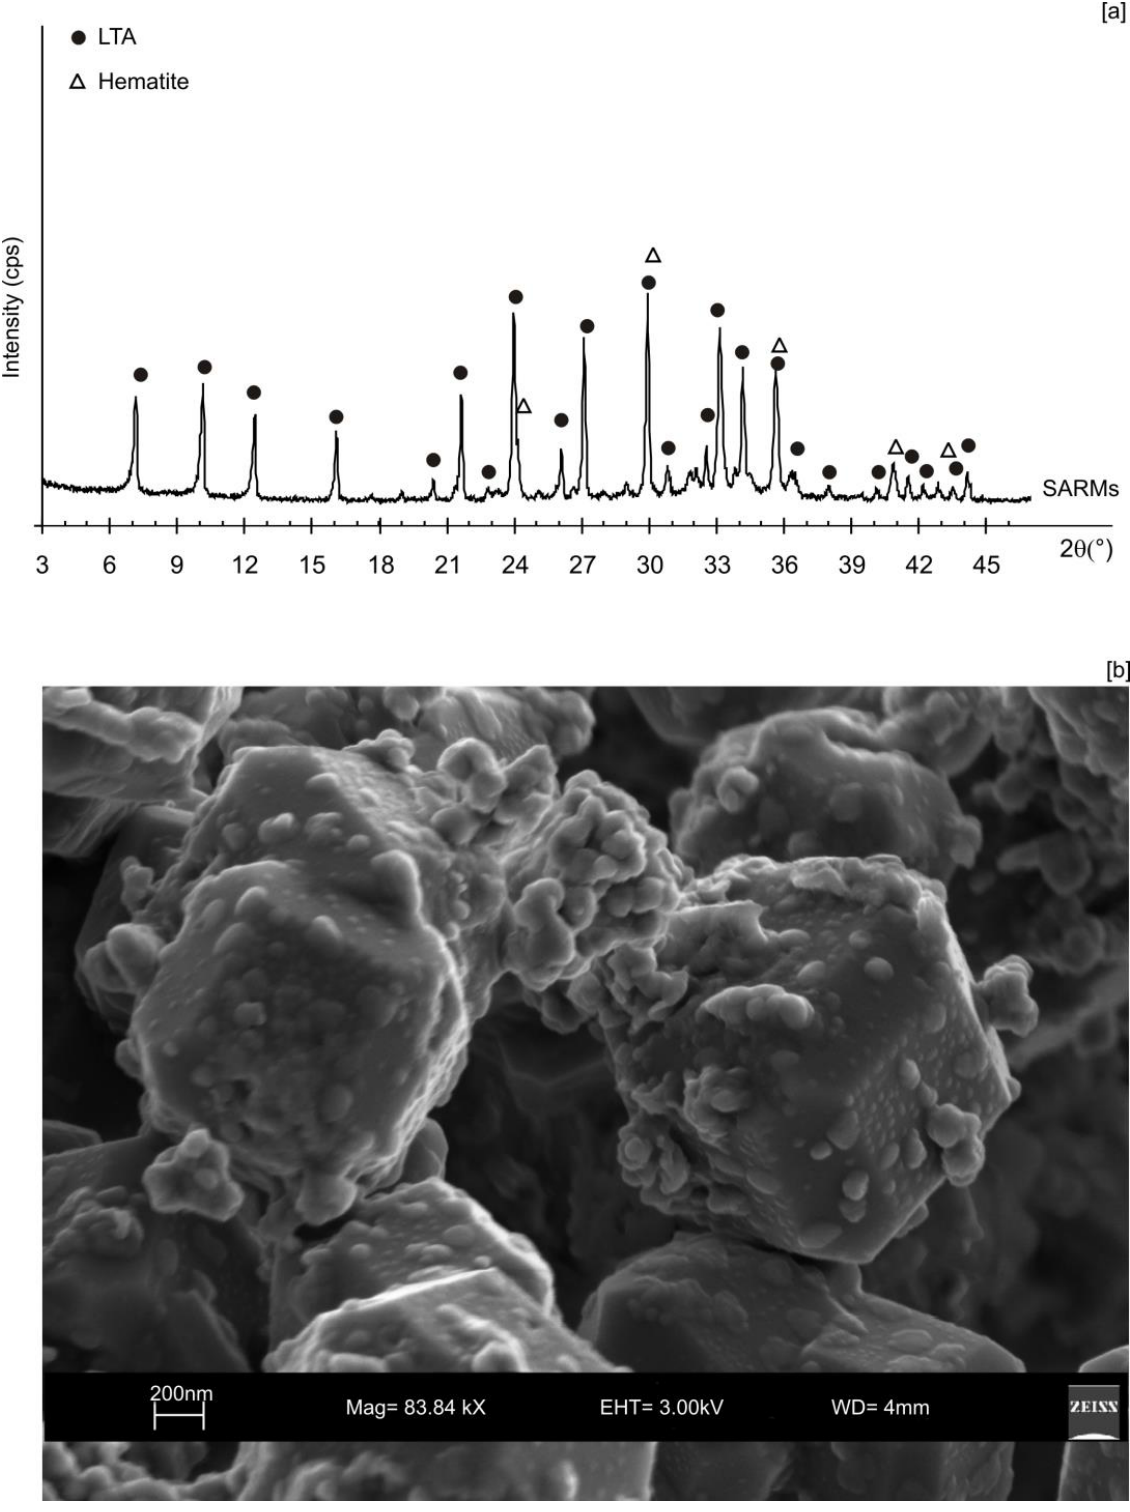
Figure 3. XRD pattern ( a ) and SEM image ( b ) of SARM